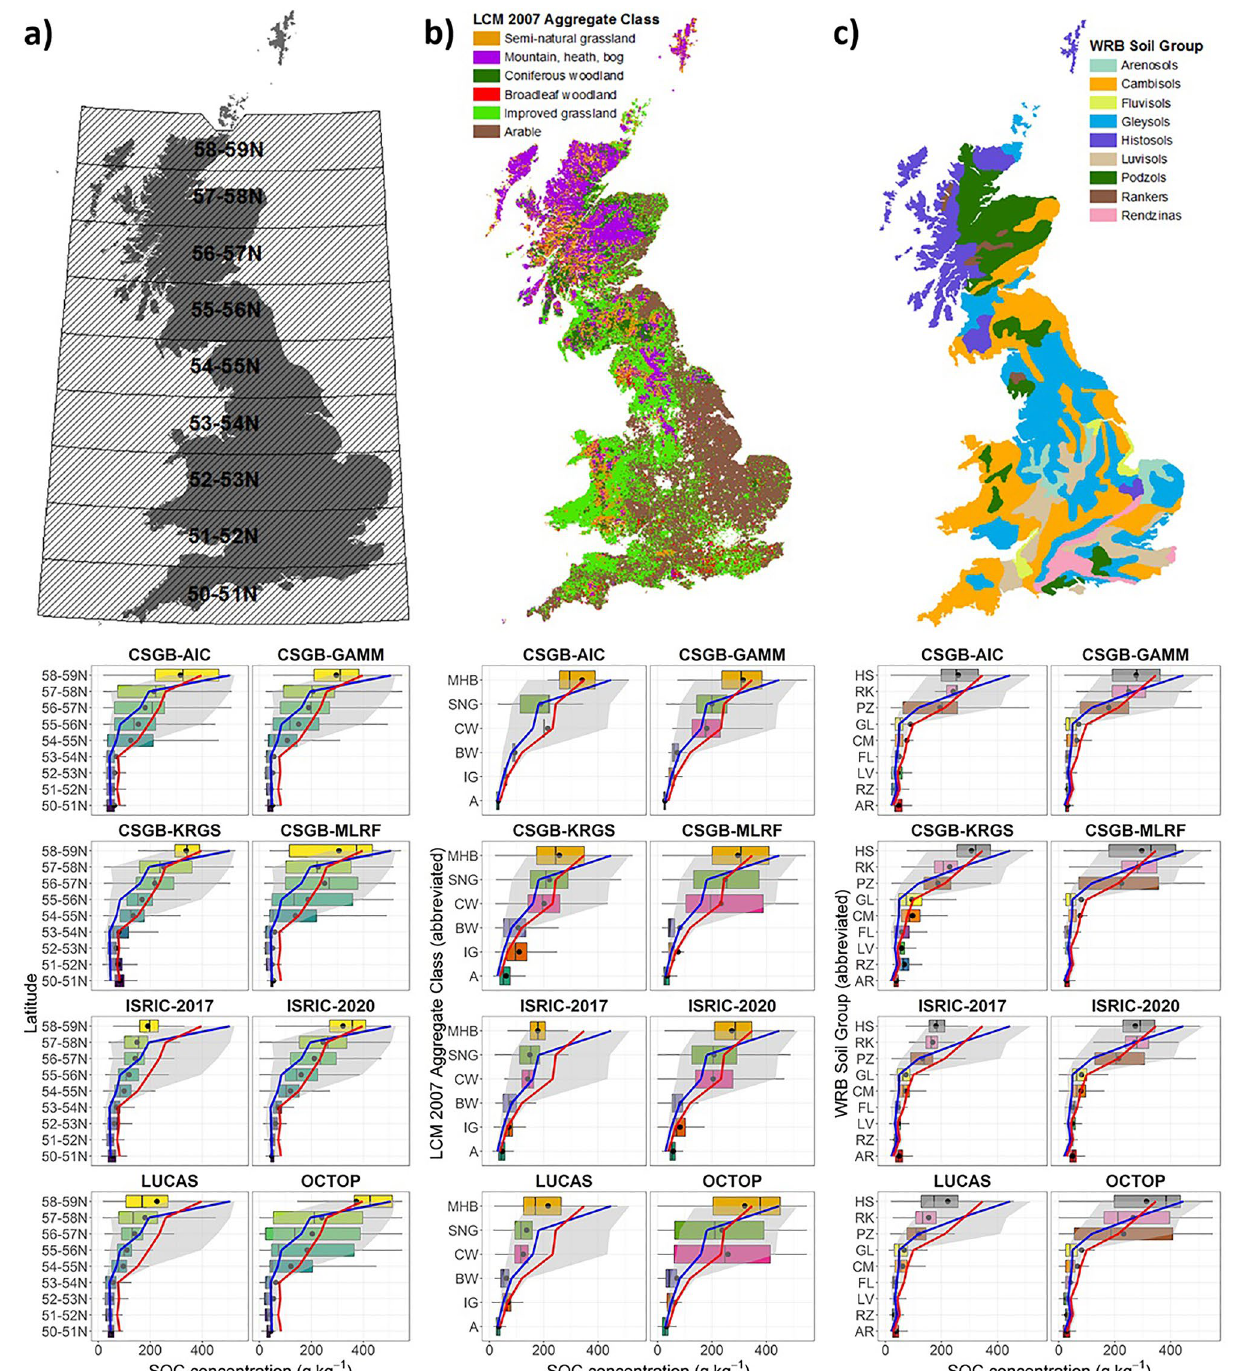
Figure 4. Topsoil SOC concentration distributions at the level of smaller-scale geographical units representing major environmental covariates, including at ( a ) each 1-degree latitude interval (excluding Orkney and Shetland due to the limited spatial coverage) to represent climate; ( b ) Land Cover Map (LCM) 2007 41 Aggregate Class to incorporate effects of land management and organisms; and ( c ) the SoilGrids250m version 2 predicted major soil types, based on the World Reference Base (WRB) map from FAO/UNESCO 42 to incorporate physical soil properties such as parent material. Boxplots are the topsoil SOC distribution modelled in all grid cells at each latitude interval for each of the eight maps (black circles are the means). The grey area is the IQR of the CS 2007 topsoil SOC distribution, and the solid blue and red lines denote the median and mean CS 2007 topsoil SOC values,